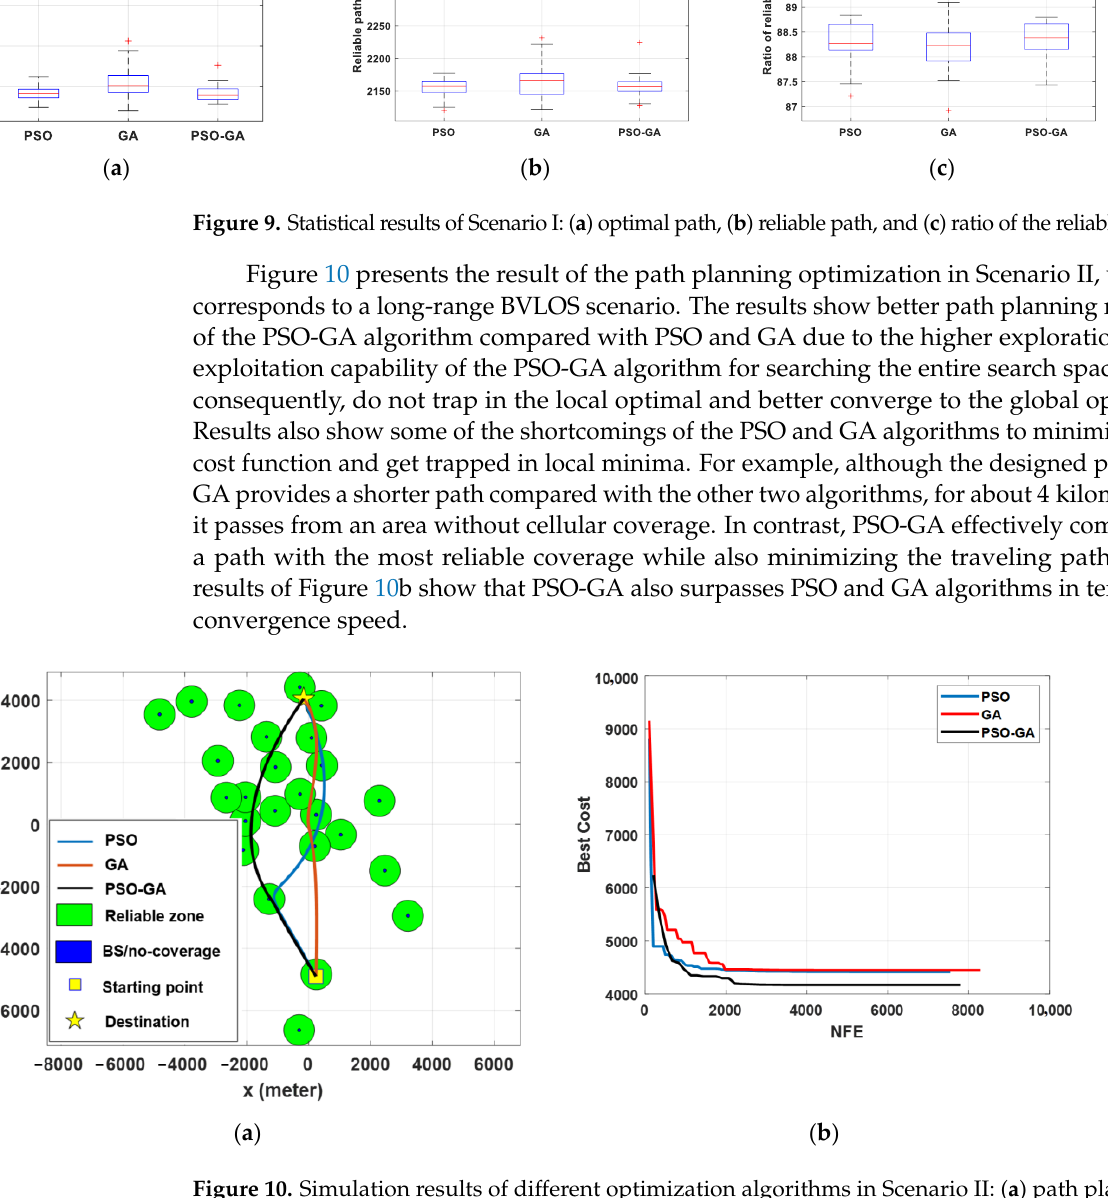
Figure 8. Simulation results of different optimization algorithms in Scenario I: ( a ) path planning results and ( b ) cost function value vs. the number of function evaluations.